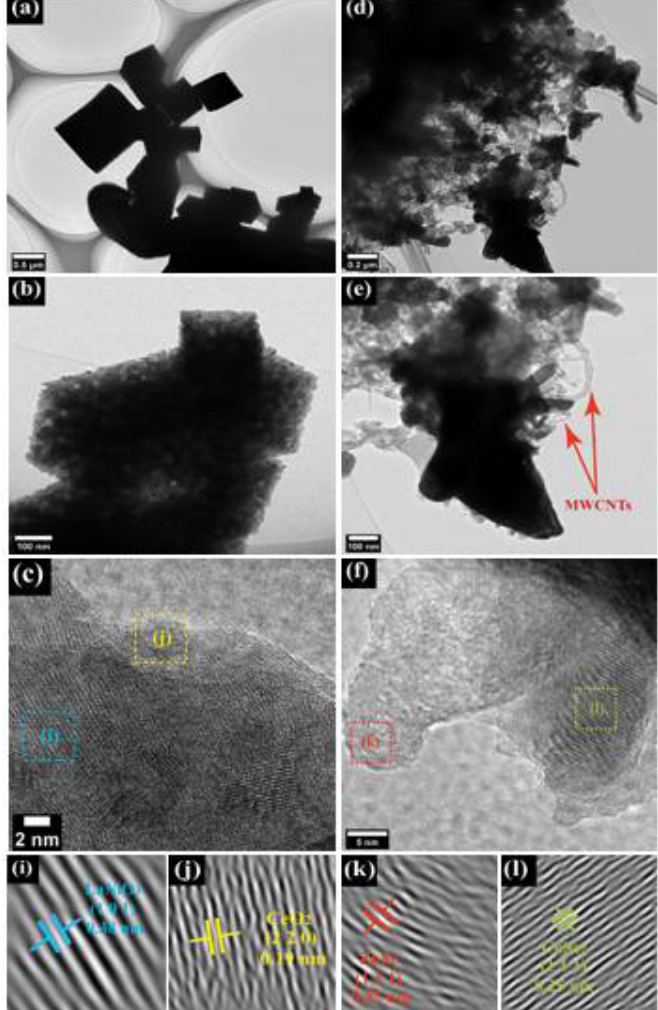
Figure 2. Typical TEM images of L ( a – c , i , j ), and F ( d – f , k , l ).